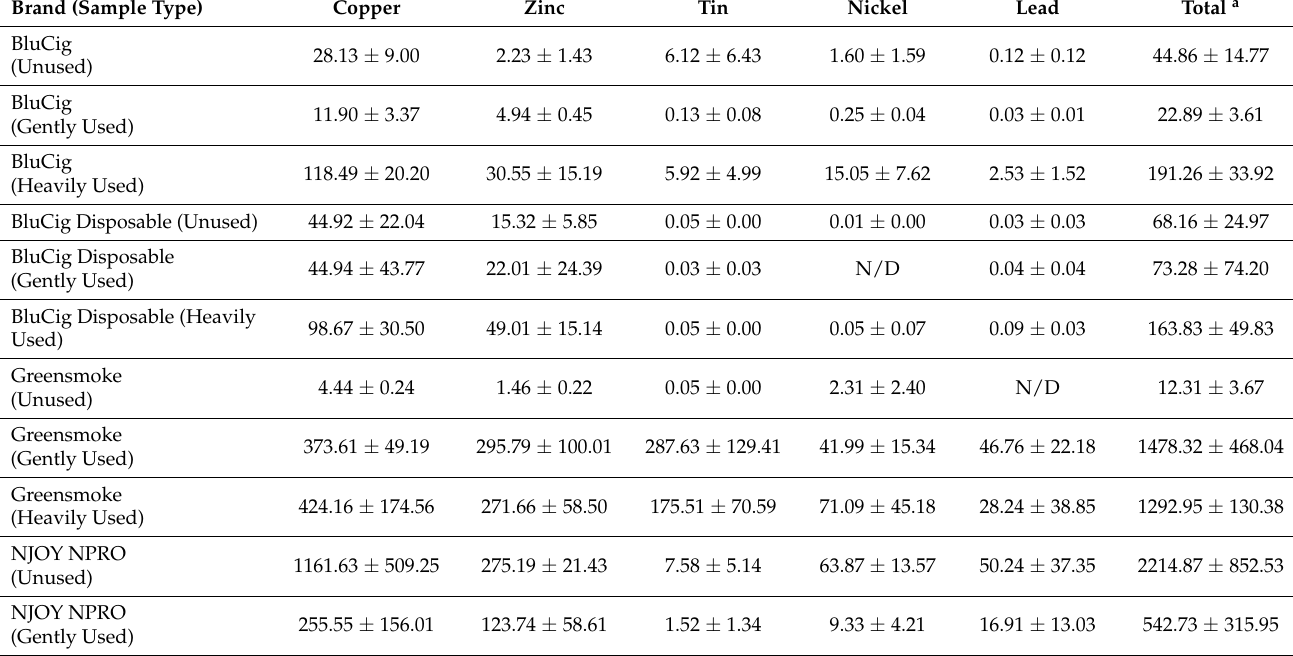
Table 1. Brand, sample types, average individual element concentrations, and total concentrations (mg/L).